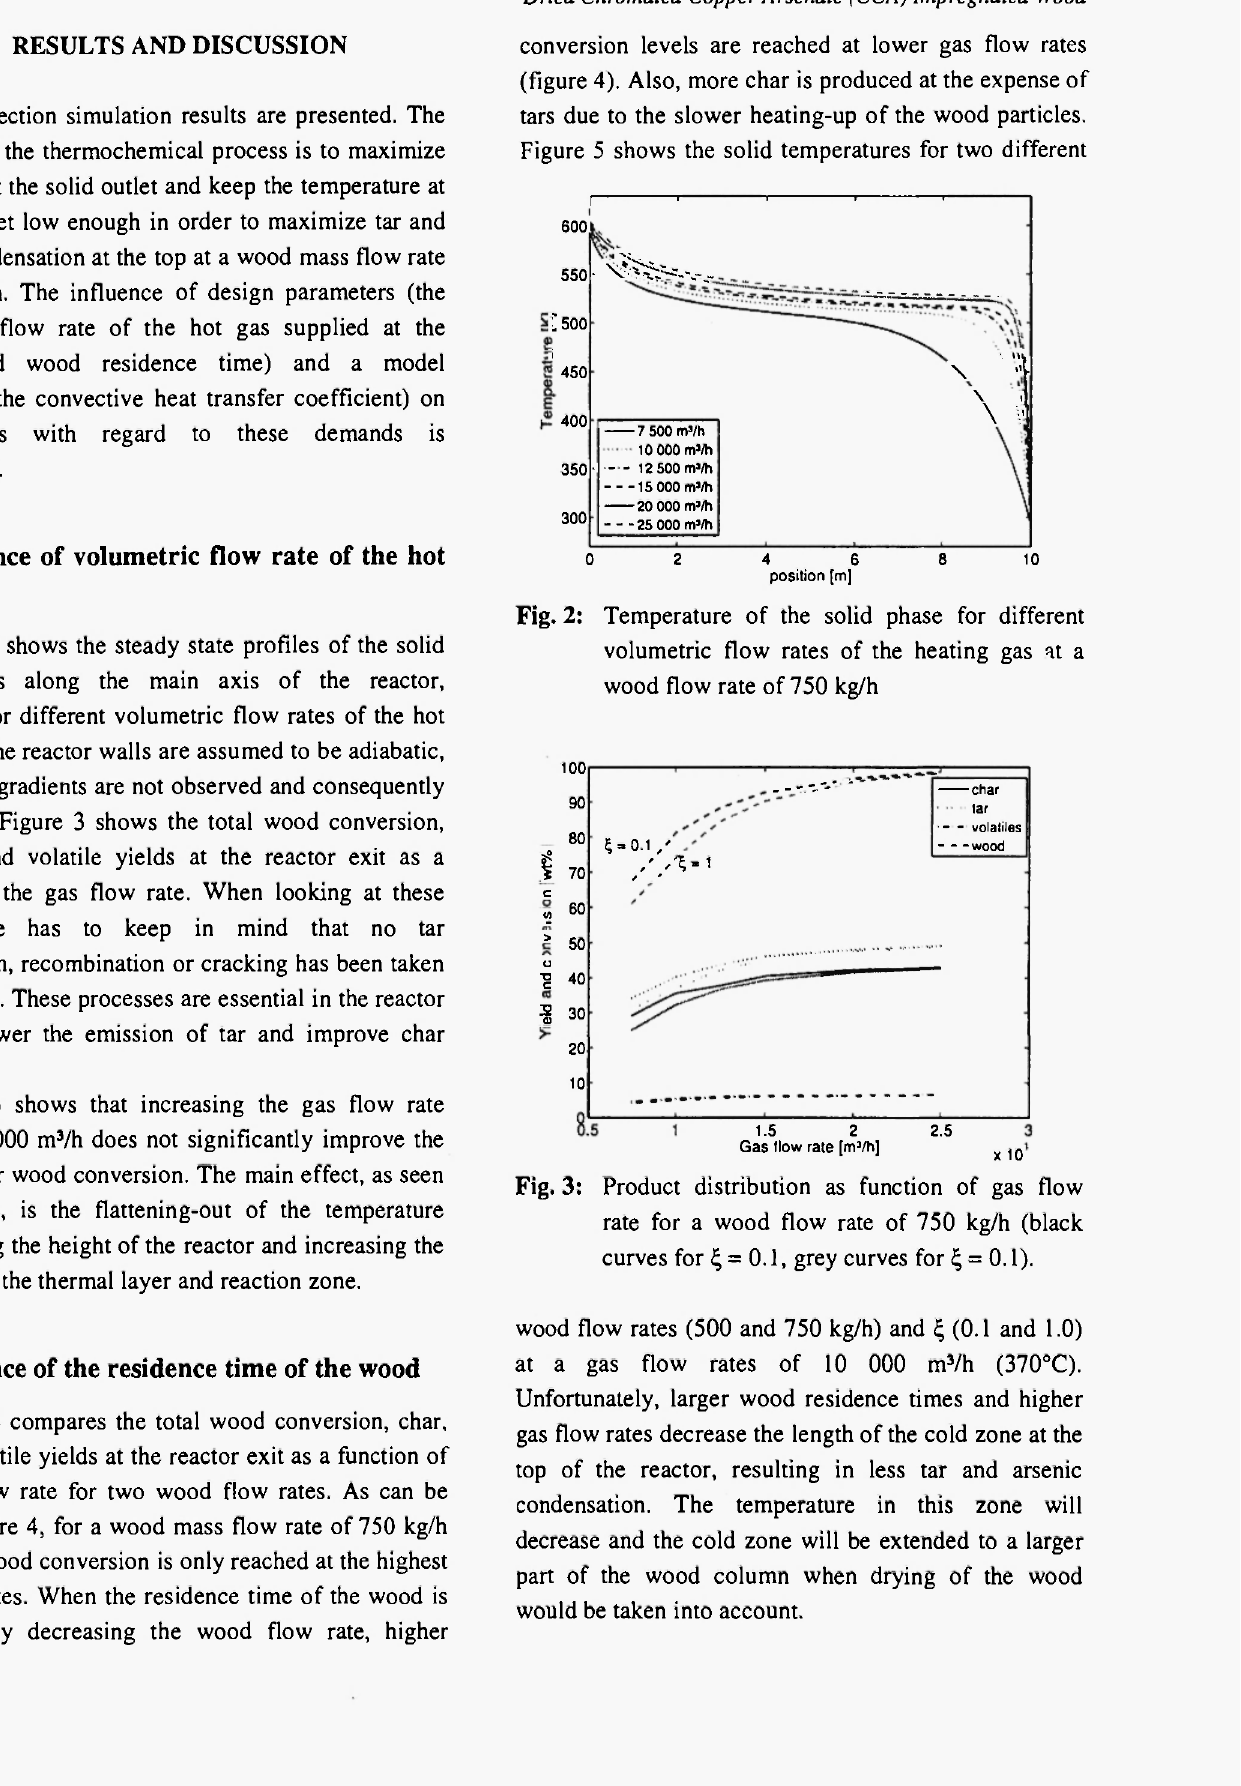
Fig. 3: Product distribution as function of gas flow rate for a wood flow rate of 750 kg/h (black curves for ξ = 0.1, grey curves for ξ =